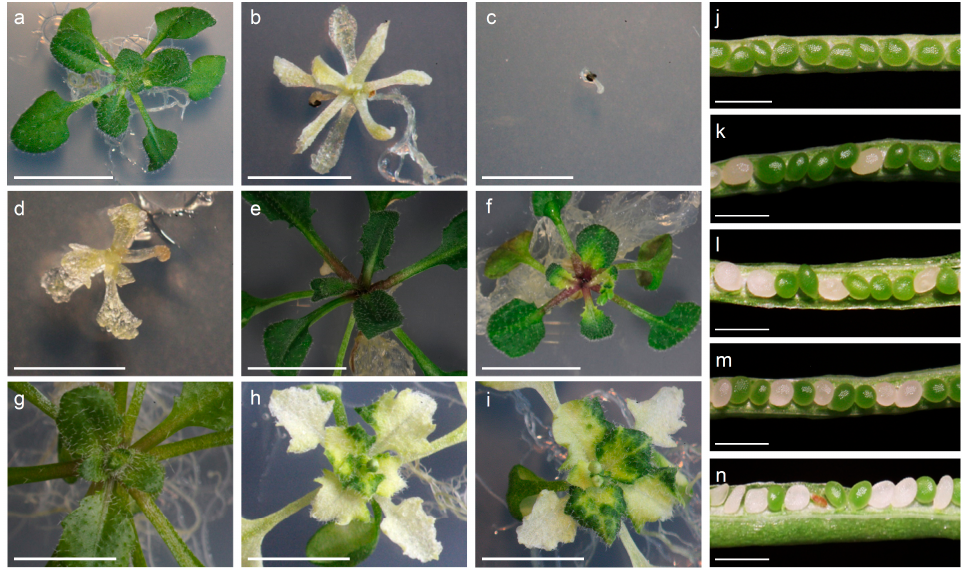
Figure 1. Phenotype of rosettes affected in the function of the At2g04030 ( EMB1956 ) gene ( a – i ) and segregation of albino embryos in the siliques of plants carrying different mutant alleles of this gene ( j – n ). ( a ) Col-0 wild-type. ( b ) Albino plant homozygous for the EMS-induced emb1956-3 allele grown in MS medium supplemented with sucrose. ( c ) Albino plant homozygous for the emb1956-3 allele grown in MS medium without sucrose. ( d ) Albino plant from the F 1 progeny of a complementation cross involving a plant heterozygous for the SALK_012235 allele and the emb1956-3 allele. Genotyping showed that this plant carries two different mutant alleles of At2g04030. ( e ) Green plant homozygous for the emb1956-3 allele complemented by the 35S::At2g04030 construct. ( f ) Variegation observed in a plant homozygous for the emb1956-3 allele due to partial complementation by a 35S::At2g04030 construct. ( g ) Col-0 wild-type. ( h , i ) Loss of pigmentation caused by the 35S::At2g04030 construct in a Col-0 background, which has previously been attributed to co-suppression [5]. The pictures were taken at 21 days ( a ), 40 days ( b , c ), 25 days ( d – f ), and 30 days ( g – i ) after sowing. ( j ) Col-0 wild-type. ( k ) emb1956-3 (EMS-induced allele described in this work). ( l ) SALK_012235. ( m ) SALK_120525. ( n ) CS16104. Scale bars: 5 mm ( a – i ) and 1 mm ( j – n ).